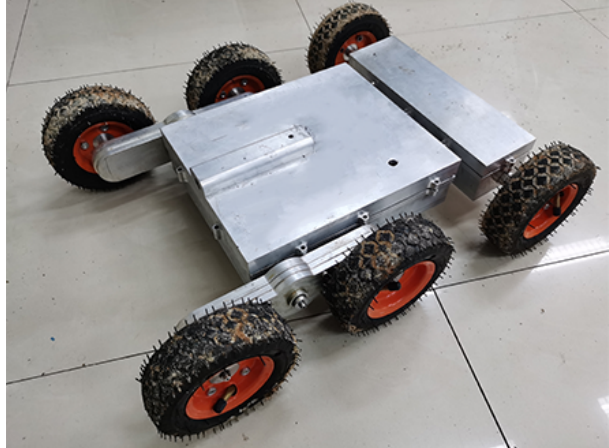
Figure 19. Physical prototype of the proposed mobile